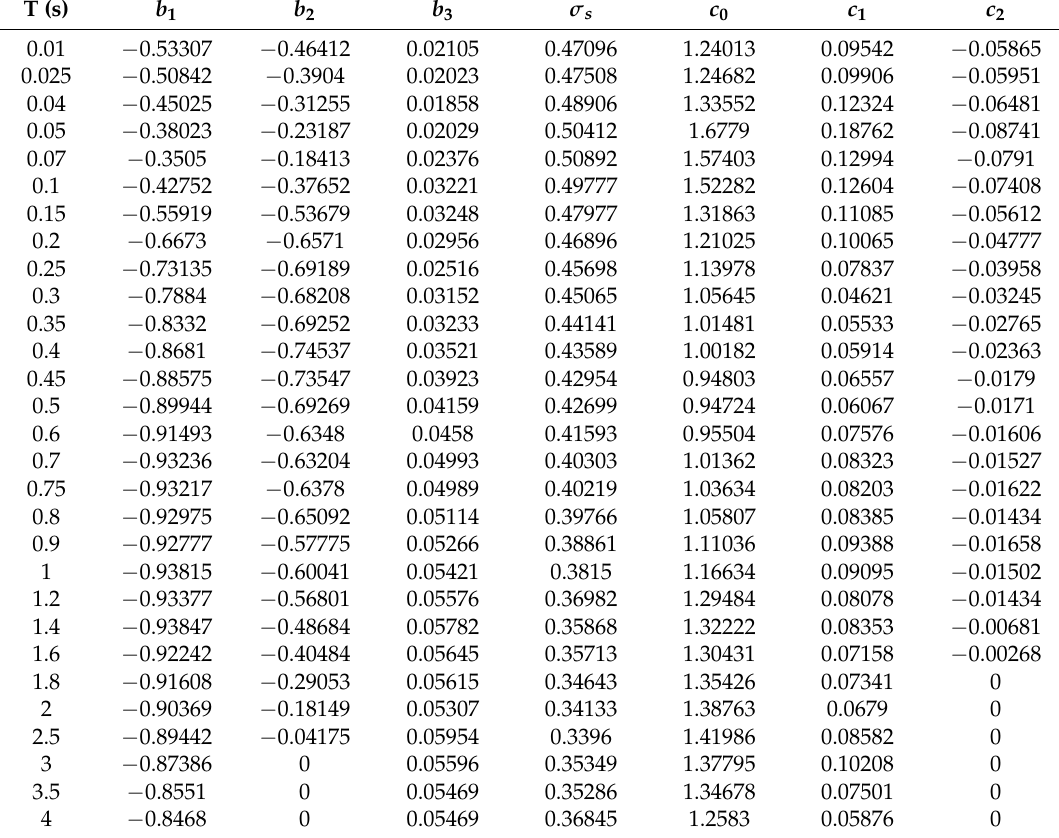
Table 2. Site model coefficients. The period independent b 4 and b 5 are 2 and 11,